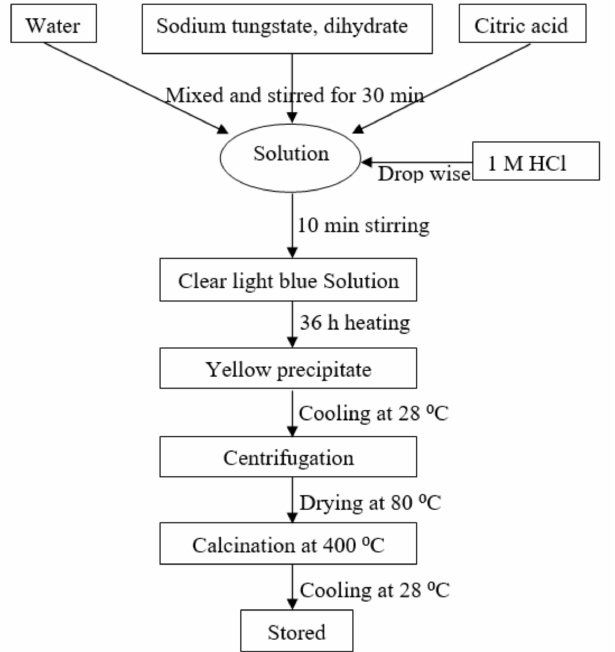
Figure 8. Flow chart of synthesis of tungsten oxide (WO 3 ) nanoplates by hydrothermal technique. PANI (Emeraldine Base)